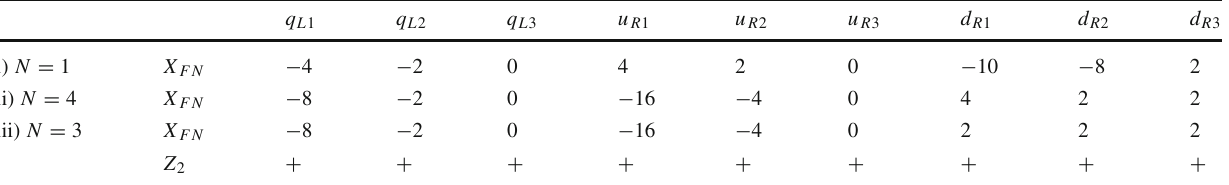
Table 2 Examples of the U ( 1 ) FN charge assignment for quarks which realizes N DW = 1 by combining with the one from the extra colored have no domain wall problem. Quarks are assumed to have no U ( 1 ) g fermions given in Table 1 charge. N represents a value of the QCD anomaly in each case, which q L 1 q L 2